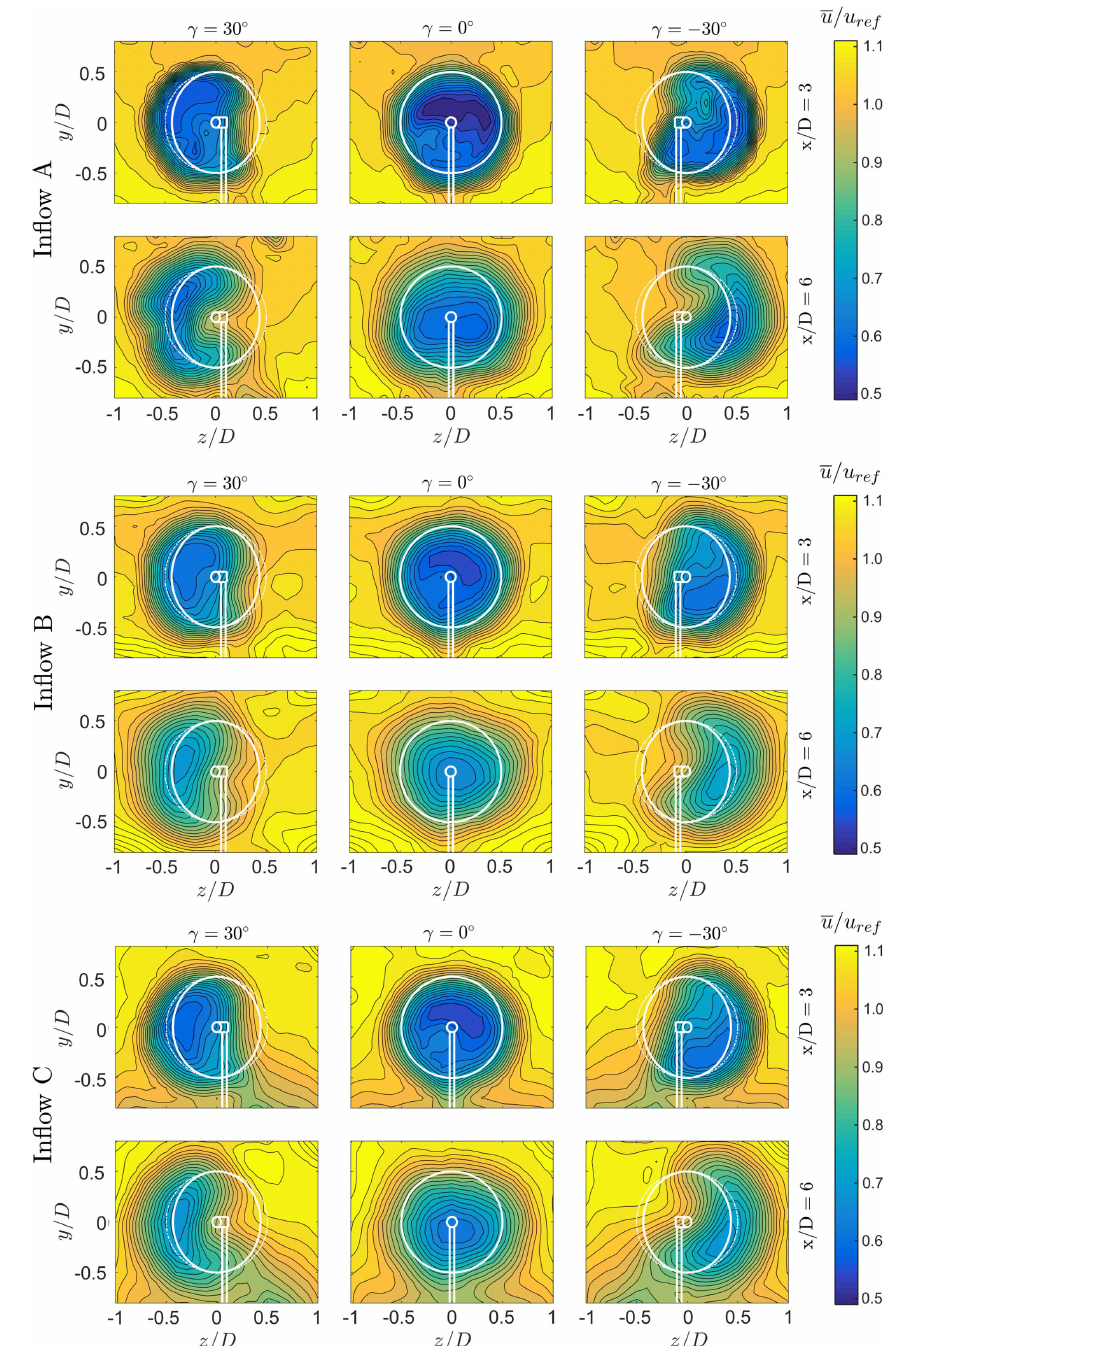
Figure 5. Normalized mean velocity components u/u ref for all measured yaw angles ( γ = − 30, 0 and + 30 ◦ ), downstream distances ( x/D = 3 and 6) and inflow conditions (A, B, and